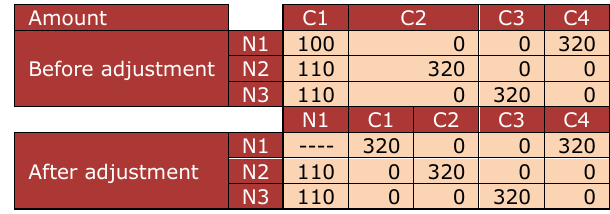
Table 3. Solution of the optimization model at cycle t=0